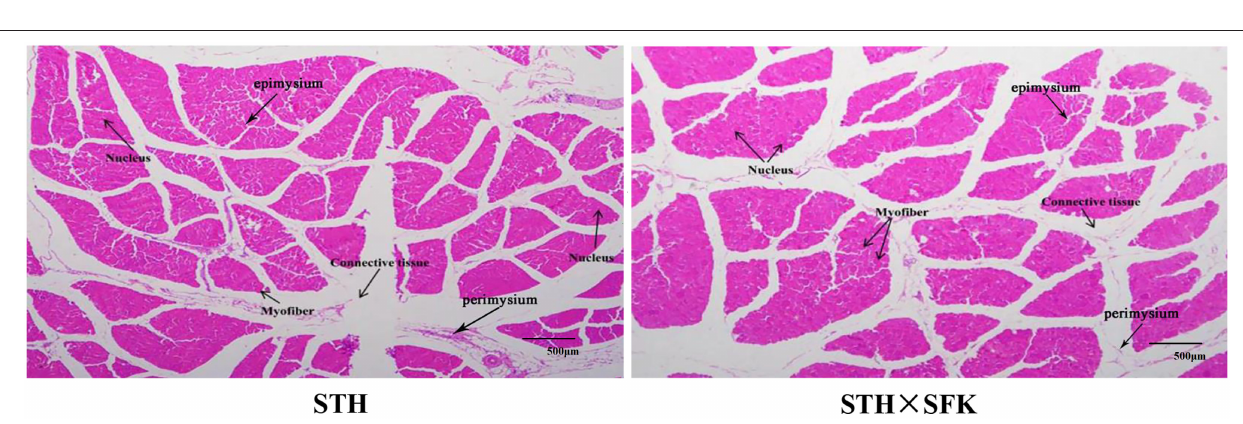
FIGURE 2 | Observation of histological morphology of longissimus dorsi muscle (HE ×